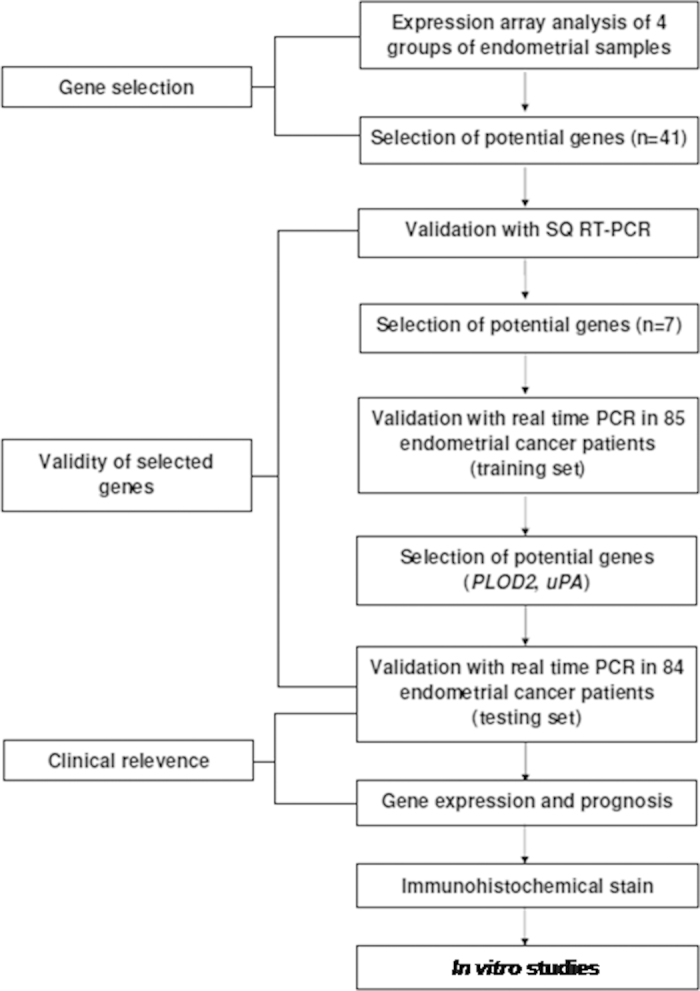
The flow chart of the study. Forty-one candidate genes were first selected by expression assay analysis, and then 7 genes were validated by SQ RT-PCR. The mRNA levels of these 7 gens were first studied in the training set (n = 85) by RTQ RT-PCR. Two potential genes (PLOD2 and uPA) selected from the training set were further investigated in the testing set (n = 84). The relevance between the clinicopathological parameters and outcomes of the patients were correlated with the mRNA expression of the genes. The protein and mRNA levels of uPA in the endometrial cancerous tissues were then correlated by immunohistochemical staining and RTQ RT-PCR. Finally in vitro experiments related to uPA in endometrial carcinogenesis were performed. SQ RT-PCR, semi-quantitative reverse transcriptase polymerase chain reaction; RTQ RT-PCR, real-time quantitative reverse transcriptase polymerase chain reaction.